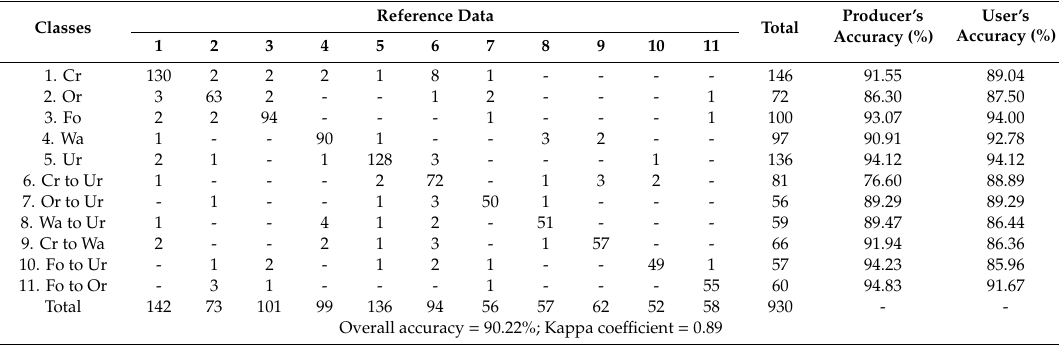
Table 4. Confusion matrix of the post-classification method,